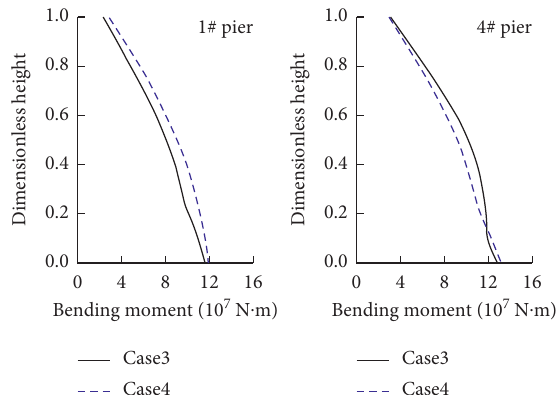
Figure 9: Bending moment envelopes of pier No. 4 in Cases 3 and 4.